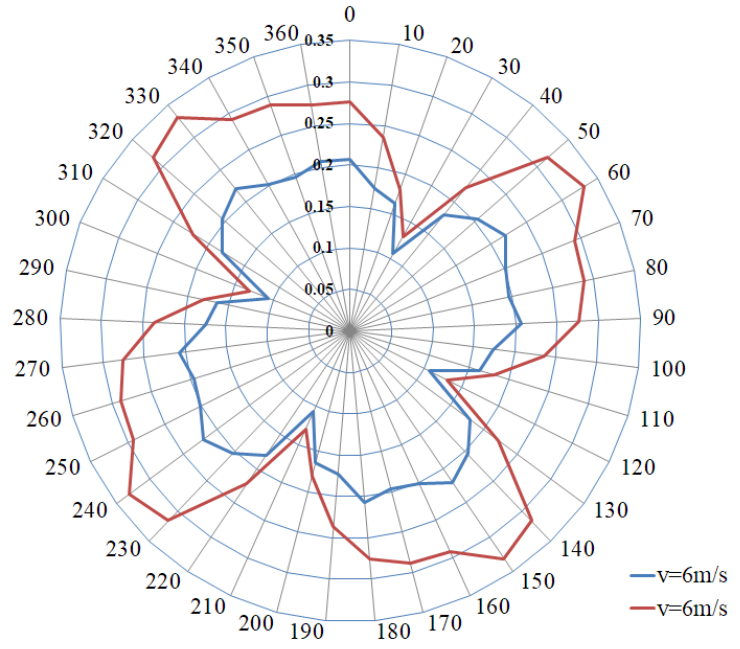
Figure 16. Radar chart of C ts of 4-bladed LDCS as a function of azimuth.